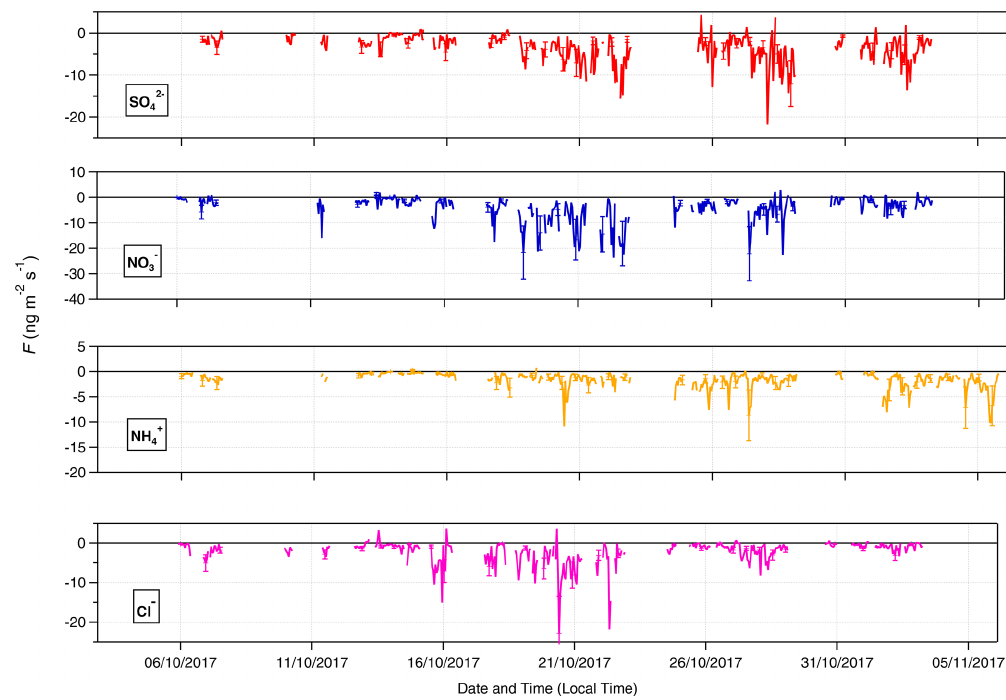
Figure 9. Time series of filtered fluxes for the aerosol counterpart species measured during the campaign.